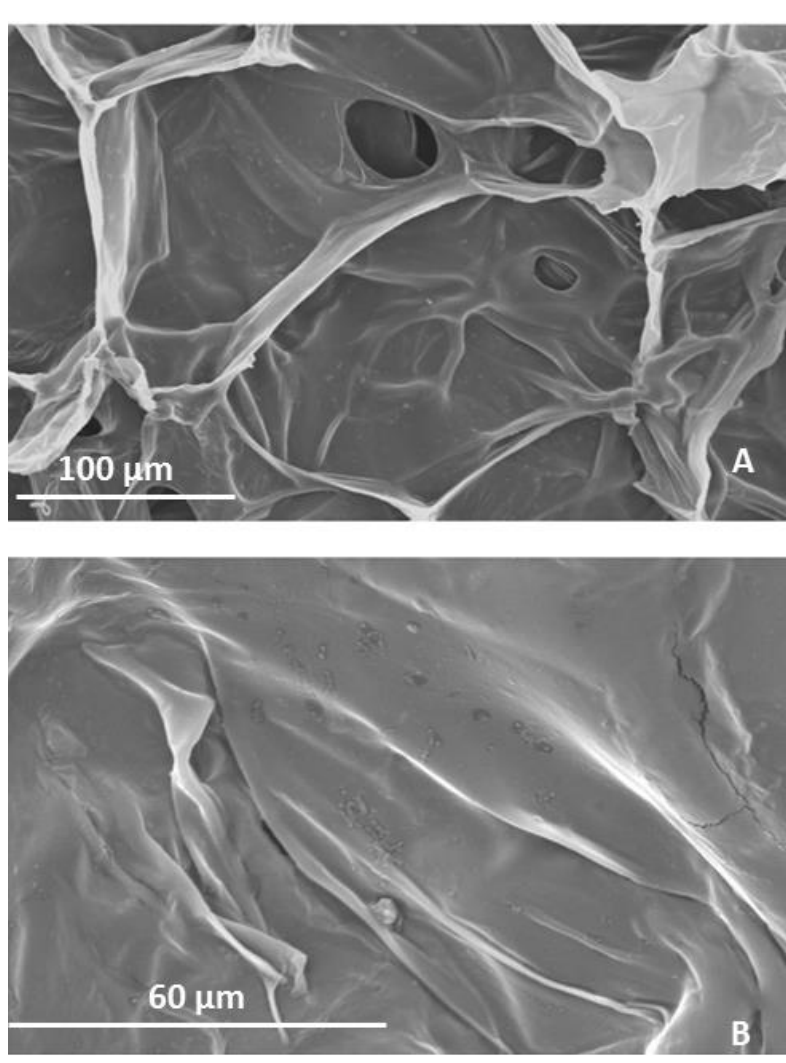
Figure 4. SEM micrographs of lyophilized WEAX containing B. longum gel at 350× magnification ( A ), 1,000× magnification ( B ) and 2,000× magnification ( C